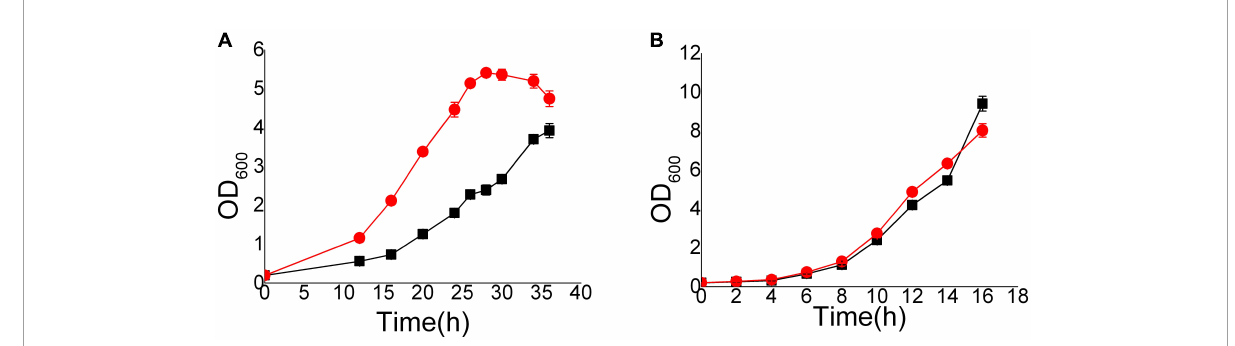
FIGURE1 Growth curves of EMV-8 and NAN-27 in medium with 8 mM vanillin stress. The cells were cultured in 40 ml SD and added 8 mM vanillin (A) or SD (B) media at 30 ◦ C, 200 rpm, starting with an initial OD600 of 0.2. Data are the mean values of triplicate tests. Symbols, red circle indicated EMV-8 and black square indicated